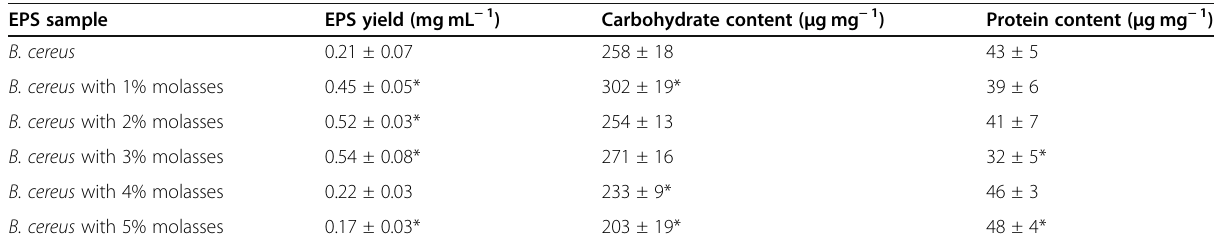
*indicates a significant difference for EPS properties from B. cereus cultured in various concentrations of molasses compared to control ( B. cereus only, without molasses) according to T-tests ( p